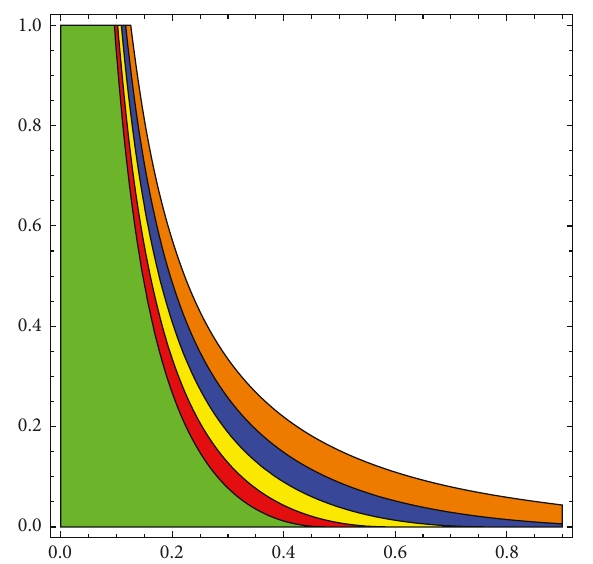
Figure 1: Domain of parameters of (6) for 𝑄 = 0.5 and 𝐾 1 = 0, 0.2, 0.4, 0.6, 0.8 represented by orange, blue, yellow, red, and green colors,